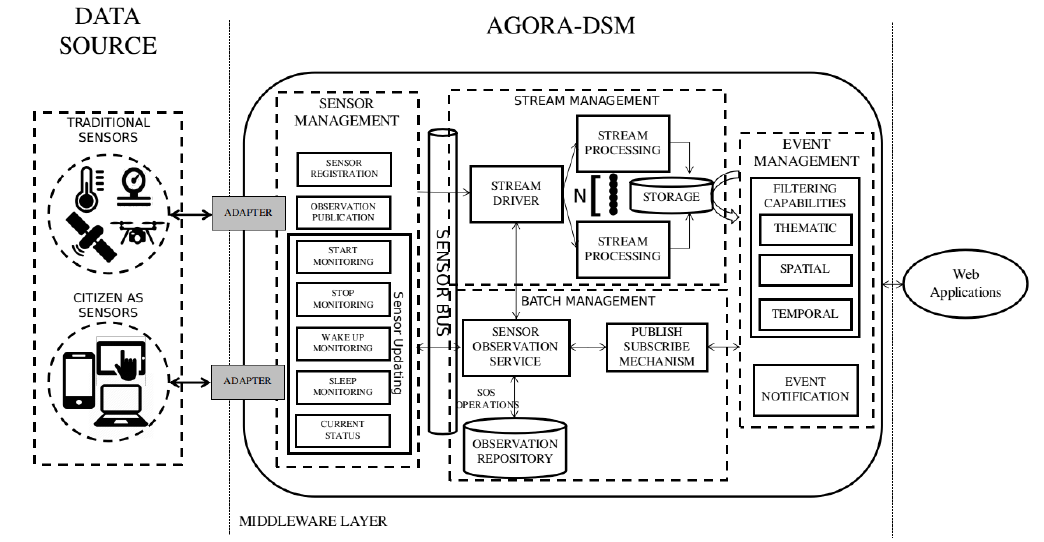
Figure 2. AGORA-DSM